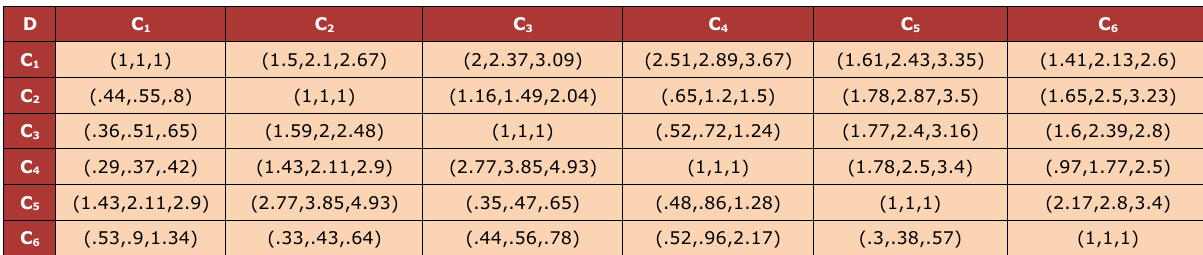
Table 5. Fuzzy pair-wise comparison matrix